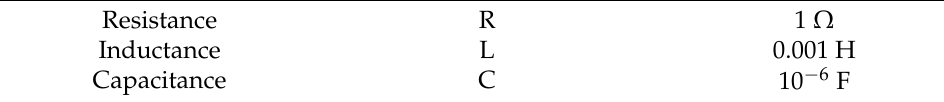
Table 3. Main parameters of the